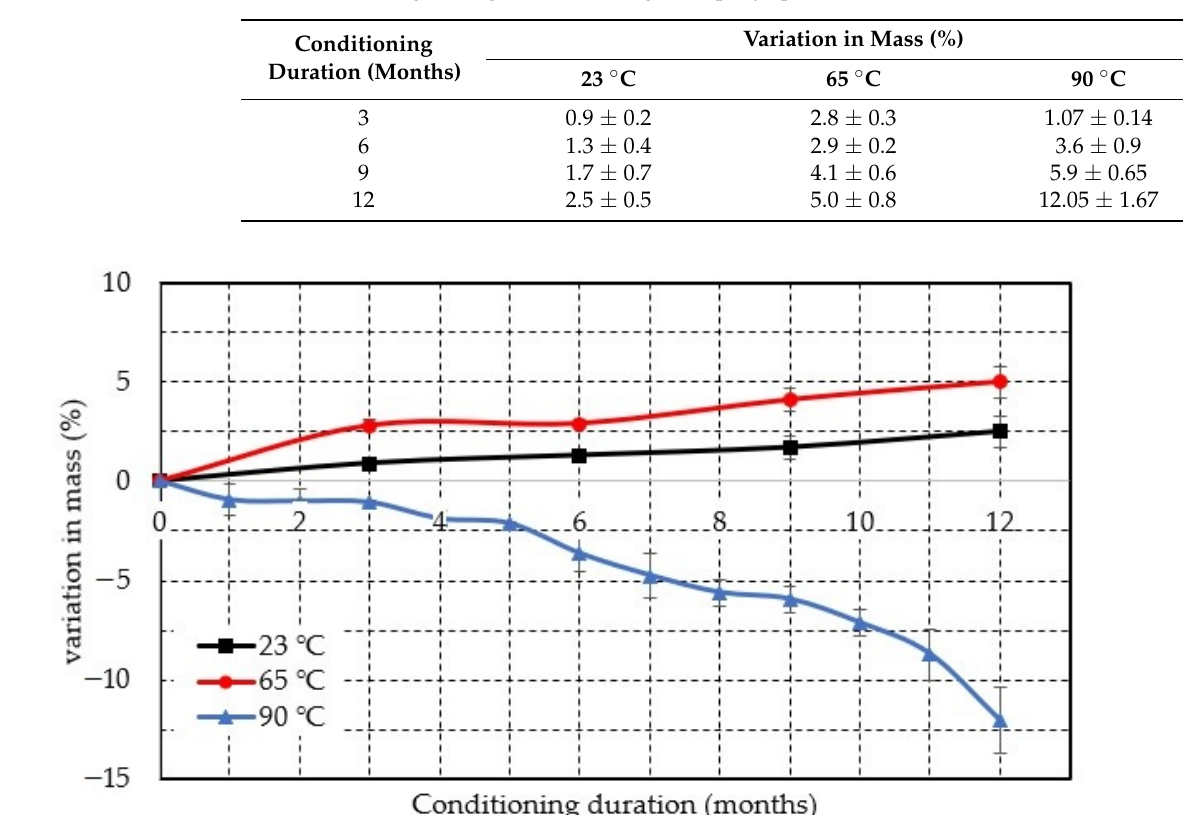
Figure 3. Effect of seawater conditioning on the mass of the specimen at various temperature.